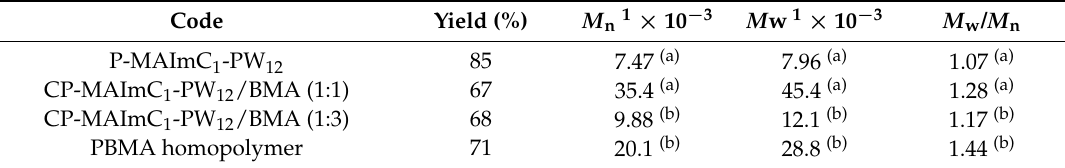
Table 2. Results of polymerizations.